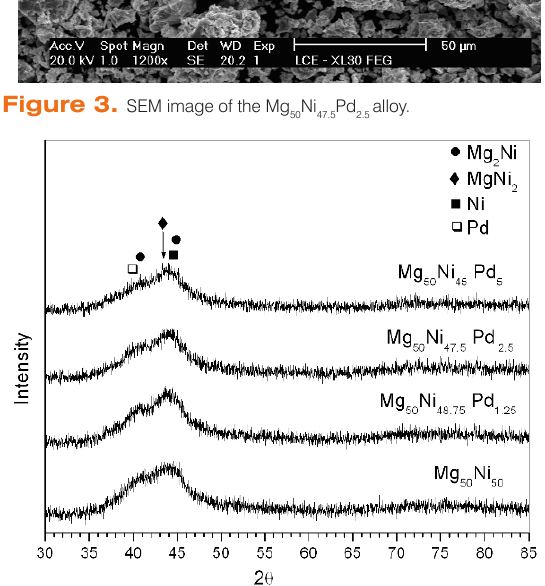
Figure 4. XRD patterns of the Mg